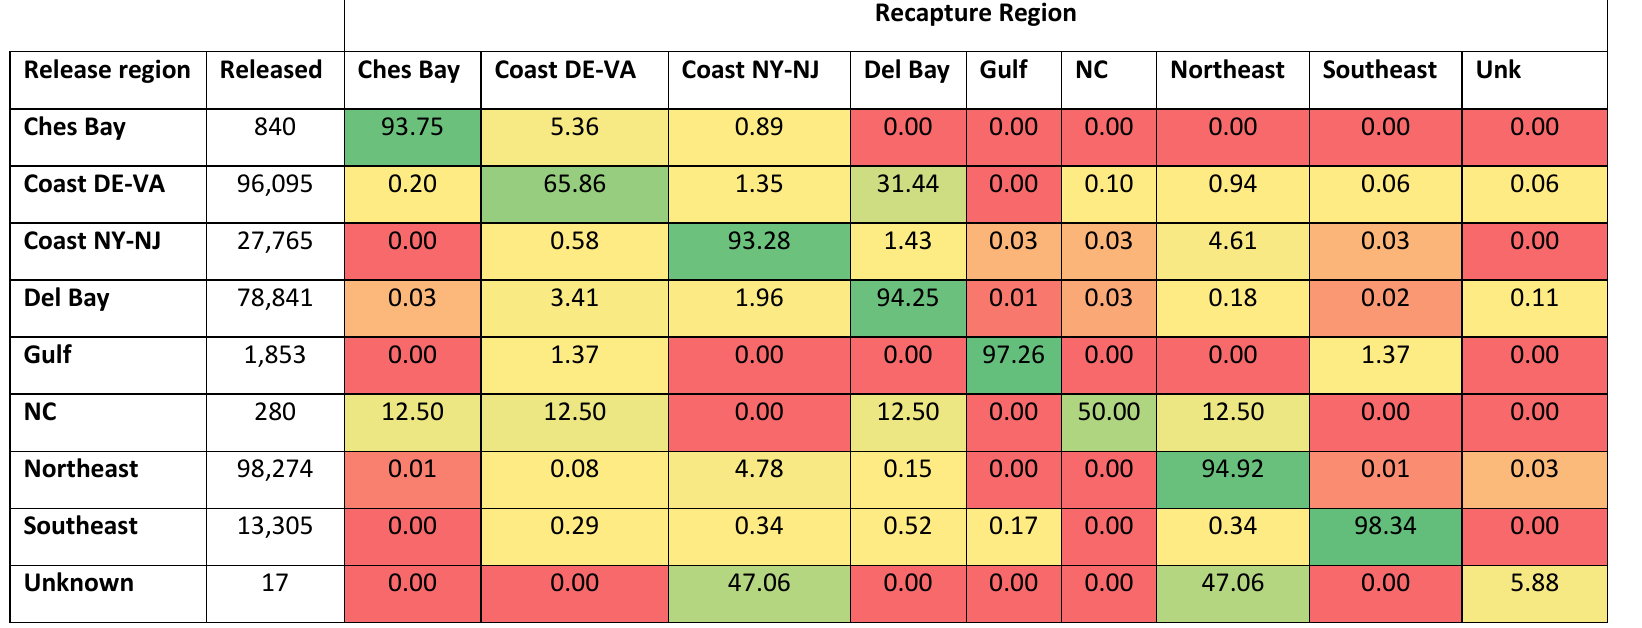
Table 4. Recapture (%) relative to total recaptures for each region of